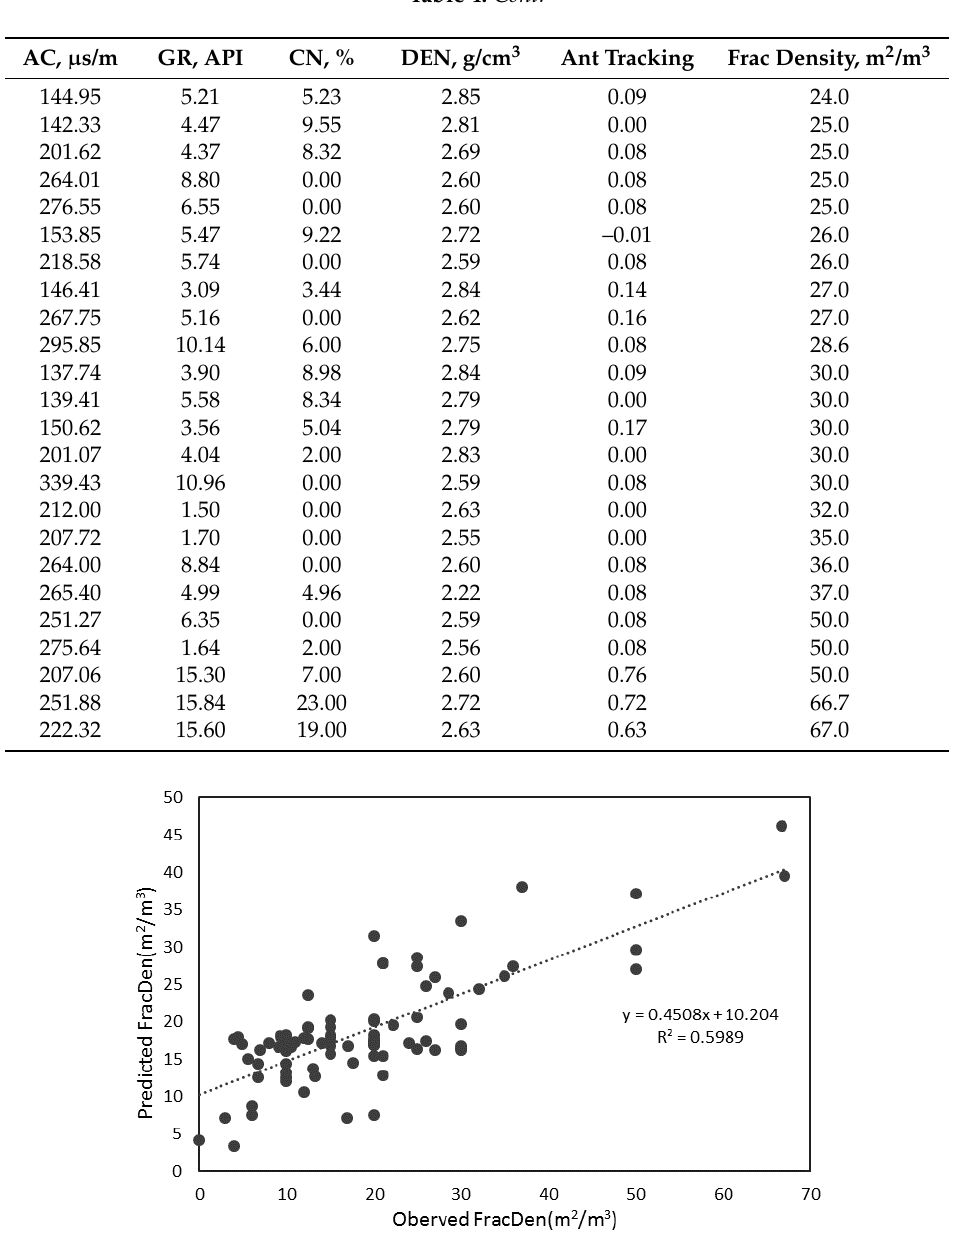
Figure 11. Observed fracture density against the predicted fracture density by the ANN model.